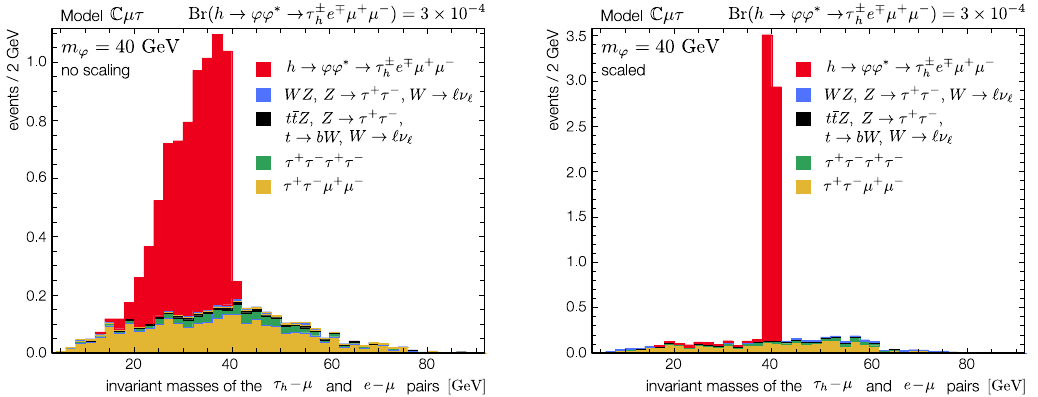
Figure 5 . The distribution for invariant masses of ( (cid:28) h ; (cid:22) ) and ( e; (cid:22) ) pairs in model C (cid:22)(cid:28) for the case with (cid:20) 6 = 0 for both signal (red) and background channels prior to ( left ) and after ( right ) the scaling procedure. In each (cid:12)gure, the mass for both ( (cid:28) h ; (cid:22) ) and ( e; (cid:22) ) are